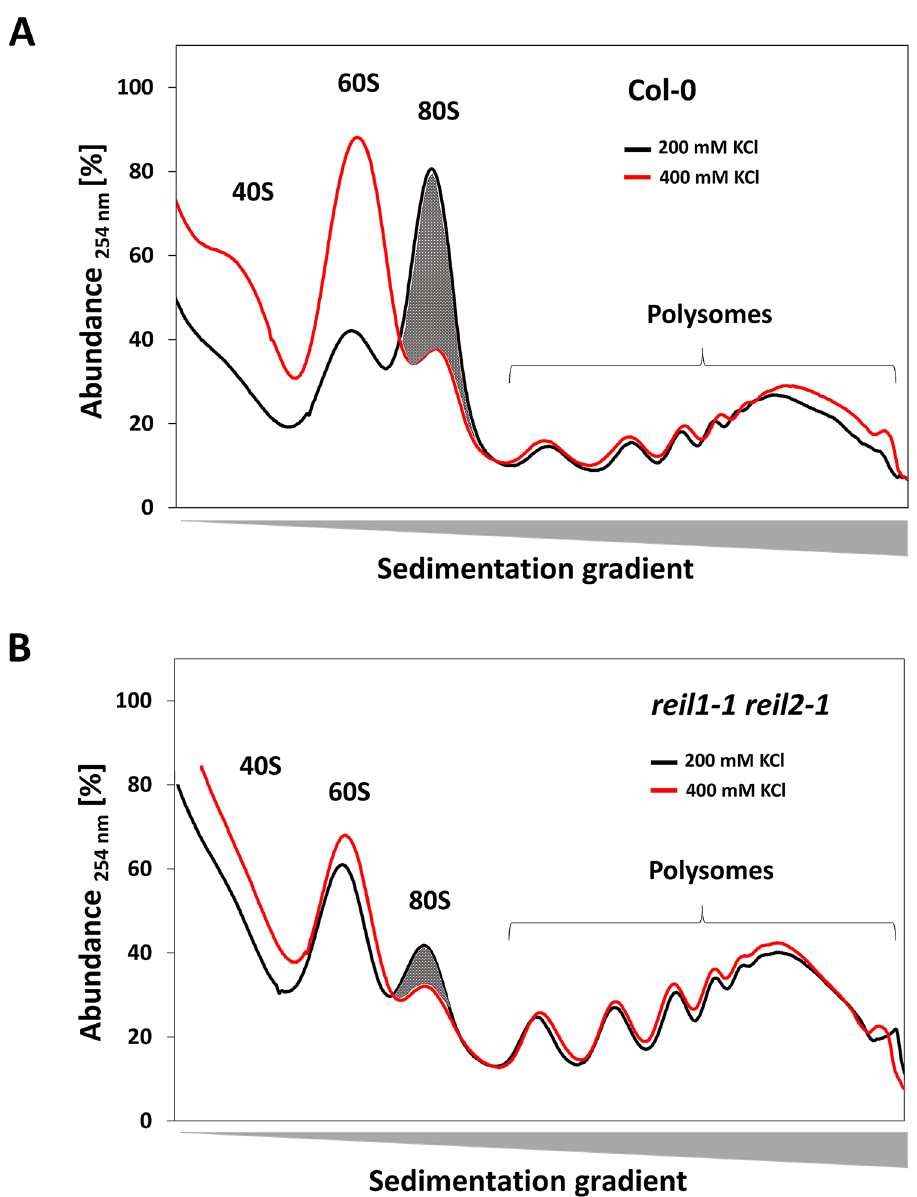
Figure 4. In vitro KCl-sensitivity test of monosomes and polysomes that were prepared from roots sampled at 21 days after start of 10 °C cold-acclimation. Arabidopsis Col-0 wild type ( A ) was compared to the reil1-1 reil2-1 double mutant ( B ). Initial samples were homogenized and split into equal technical replicates. These replicates were extracted with PEB that either, contained a normal KCl concentration (200 mM, black) or an elevated KCl concentration (400 mM, red). Note that the acclimated wild type accumulated a large fraction of KCl-sensitive monosomes, whereas KCl-sensitive monosomes were almost absent from cold acclimated reil1-1 reil2-1